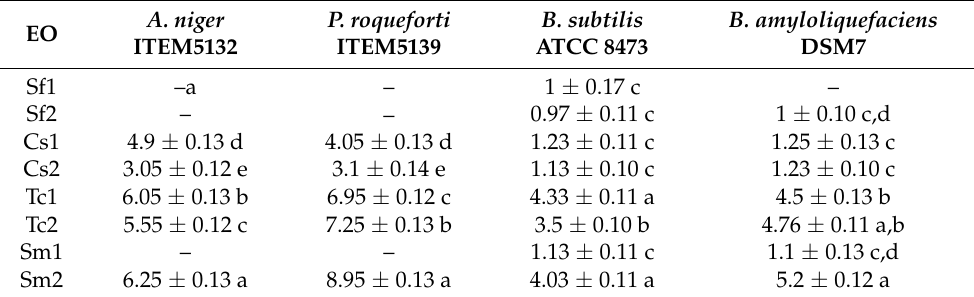
Table 4. Screening of the antimicrobial activity of EOs against A. niger ITEM5132, P. roqueforti ITEM5139, B. amyloliquefaciens DSM7, and B. subtilis ATCC8473 using the disk diffusion assay. A. niger EO